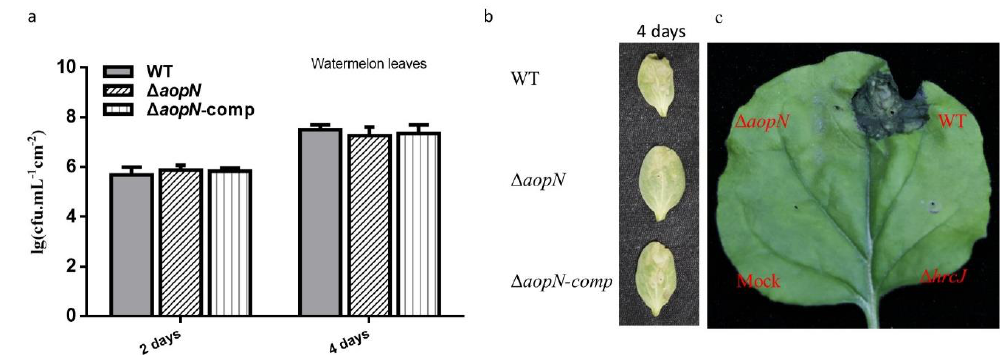
Figure 3. Virulence analysis of AopN. ( a ) Bacteria population levels of wild-type (WT) strain, aopN